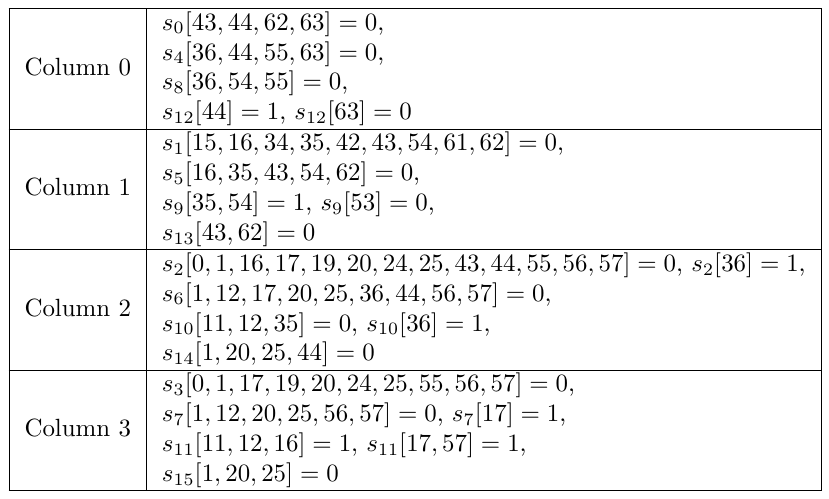
Table 6: Conditions on the initial state for